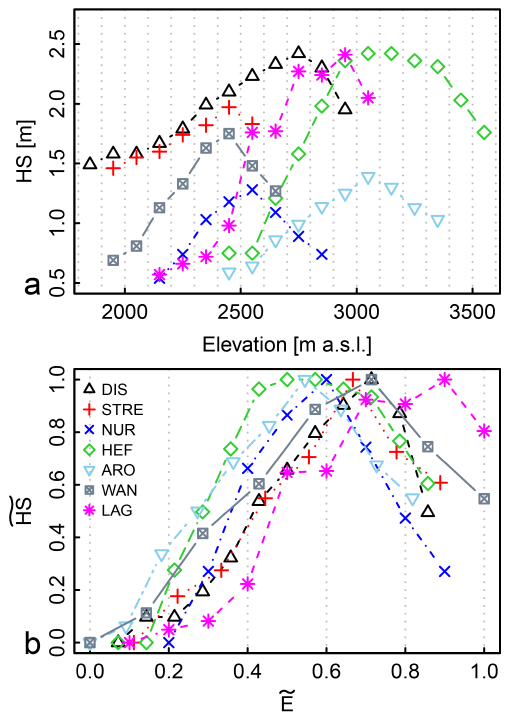
Figure 5. Elevation gradients on the scale of the complete data sets. In (a) snow depths are plotted against Elevation as raw values (b) and re-scaled by applying Eq. () to snow depth and